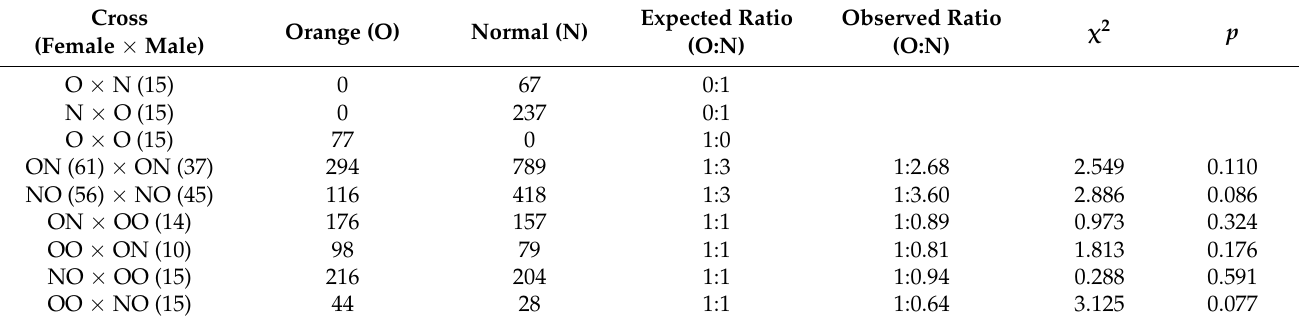
Table 1. Nymphs color in offspring of crosses and backcrosses between mutant (orange) and wild (normal) Orius laevigatus